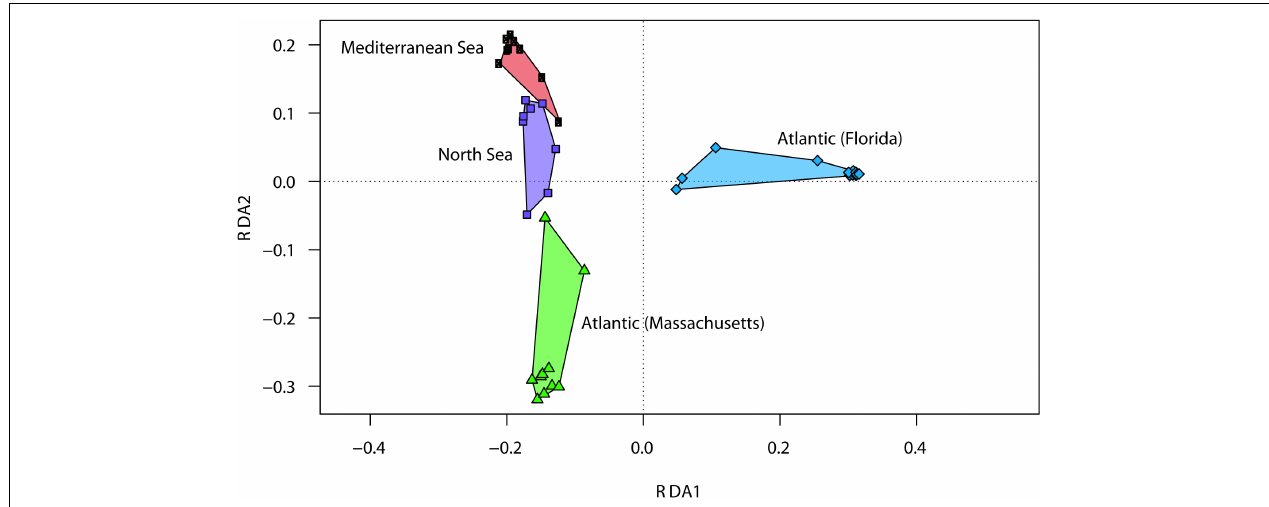
FIGURE 3 | Redundancy analysis (RDA) models of Hellinger-transformed OTU abundances comparing Mnemiopsis leidyi associated bacteria of different sub-populations. Distance plots of RDA model of Hellinger-transformed OTU abundances. Each point represents the whole microbiota community of an individual sample associated with the respective native and invasive sub-population. Groups of related sample points are framed by polygons filled with a corresponding color.